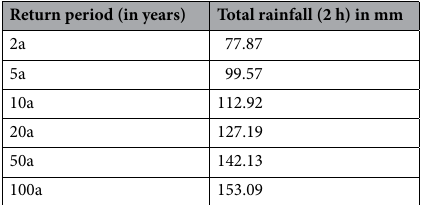
Table 1. Return period and corresponding total rainfall over 2 h.